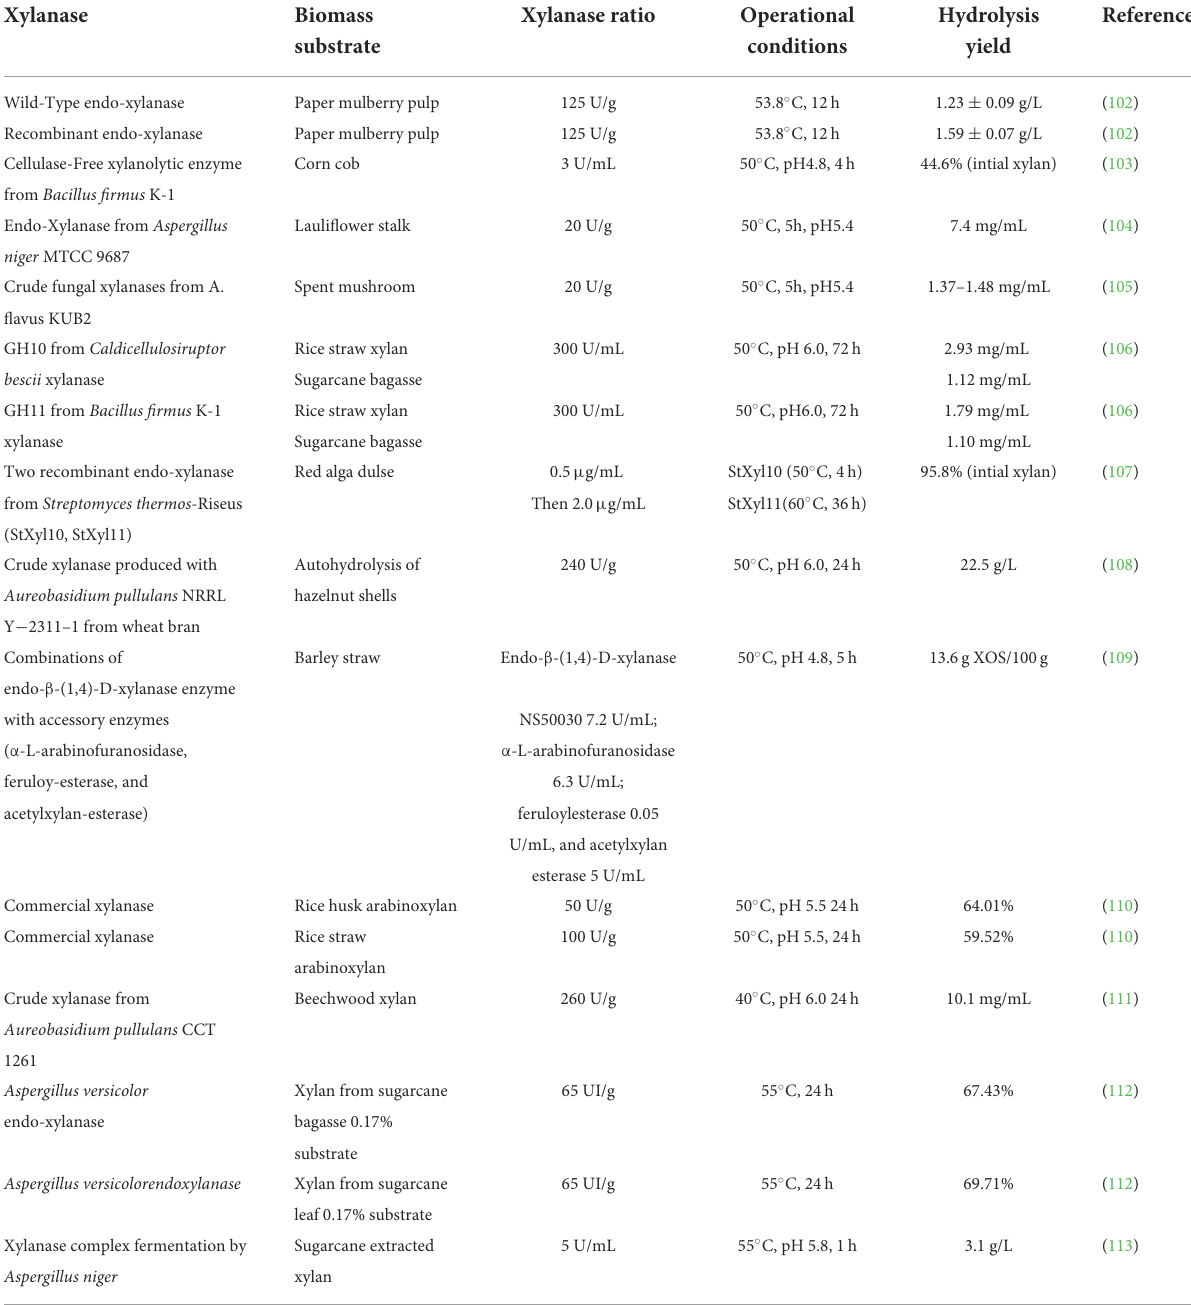
TABLE 3 Xylanase used for XOS production, operational conditions, and yield. Xylanase Biomass